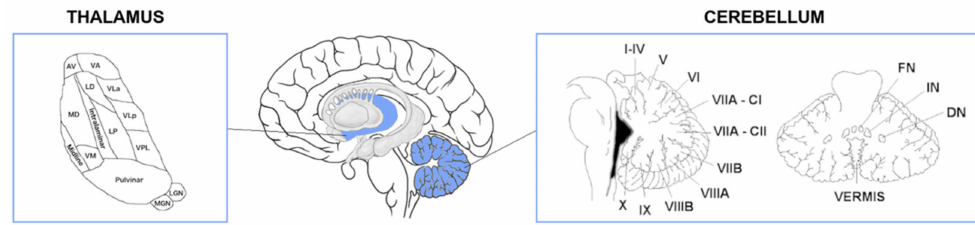
Figure 1. Regions of interest used in the analysis. Abbreviations. Thalamus: AV—anteroventral, VA— ventral anterior, LD—laterodorsal, VLa—ventral lateral anterior, MD—mediodorsal, LP—lateral pos- terior, VLp—ventral lateral posterior, VPL—ventral posterolateral, VM—ventromedial, LGN—lateral geniculate nucleus, MGN—medial geniculate nucleus. Cerebellum: VIIA-CI—lobule VIIA Crus I, VIIA-CII—lobule VIIA Crus II, FN—fastigial nucleus, IN—interposed nucleus, DN—dentate